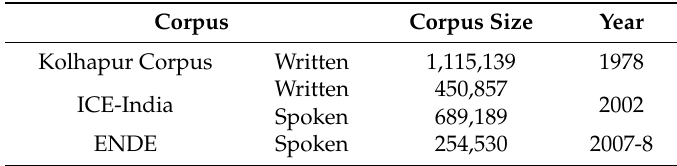
Table 1. Details of each IE (Indian English) corpus and sub-corpus.